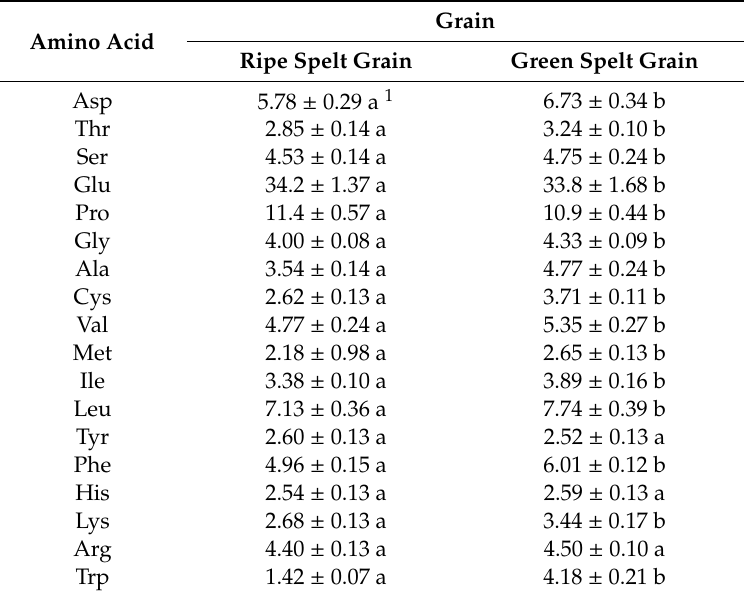
Table 5. The content of amino acids in spelt grain [mg g − 1